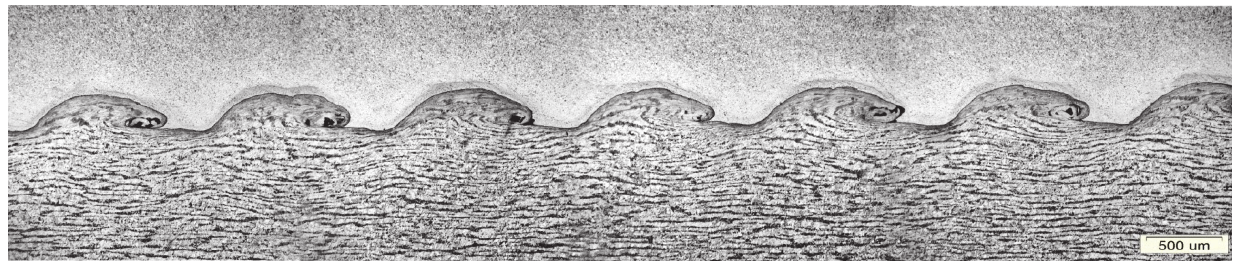
Figure 1: Wavy interface line in steel – titanium bimetal.